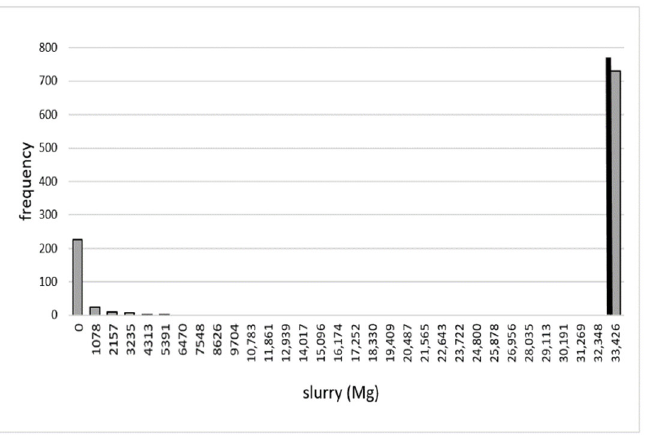
Figure A28. Histogram showing frequencies of achieving given quantity of sales of slurry for mine “G” with σ yprog .